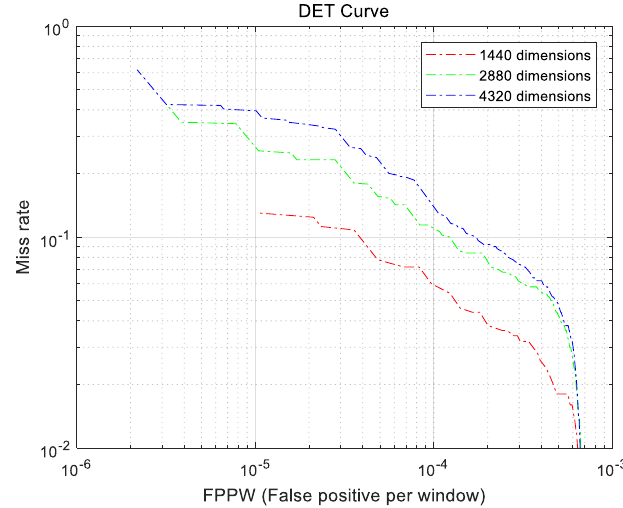
Figure 12. Dimensionality effects.